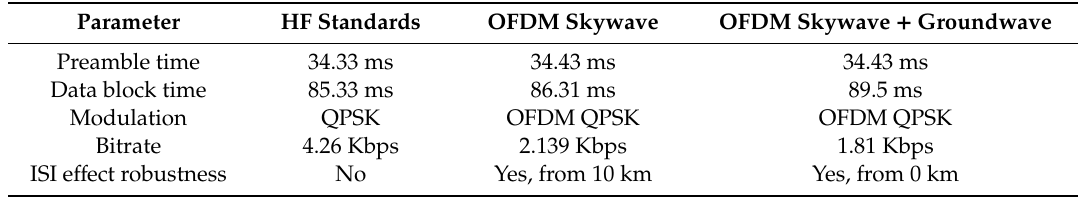
Table 4. Main frame protocol di ff